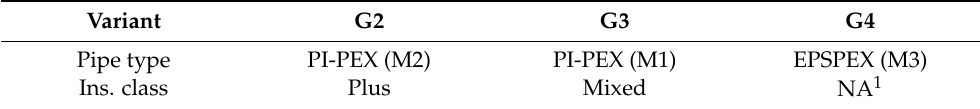
Table 7. GRUDIS variants—Overview of different pipe combinations used to simulate